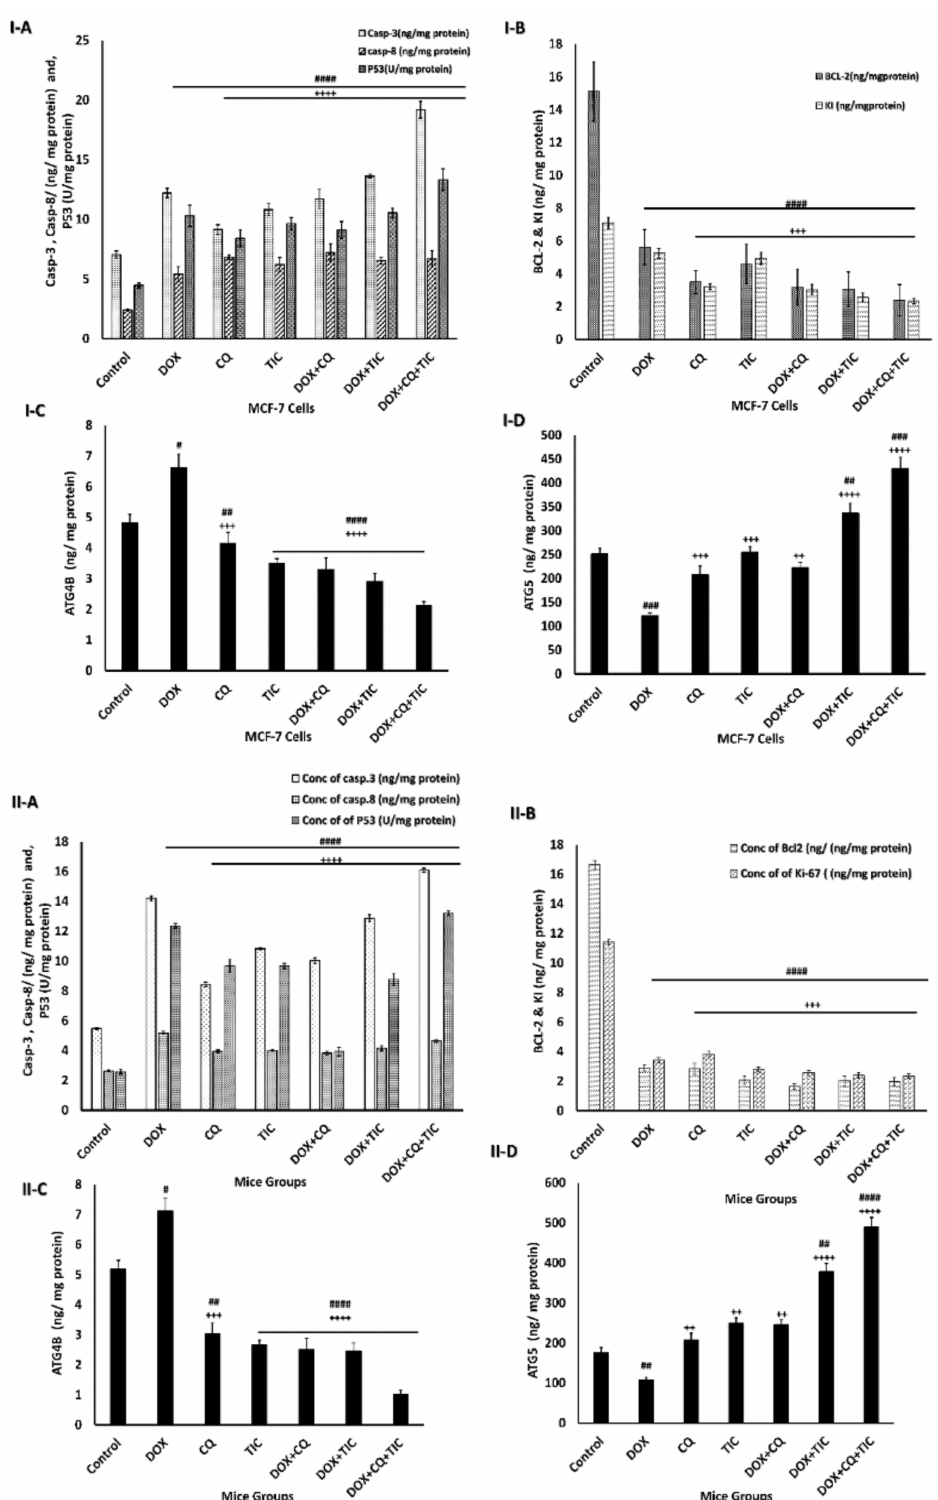
Figure 8. The disparity of apoptotic, anti-apoptotic, autophagy markers. Bar diagrams showing apoptotic markers as caspase-3, caspase-8, P53 ( A ), Bcl2, KI-67 as proliferation markers ( B ), ATG4B ( C ) and ATG5 ( D ) as autophagic markers of MCF-7 cells ( I ) and MCF-7 Xenograft mice ( II ) treated with single or combinatorial treatments. The data are presented as mean ± SE of at least three independent experiments. # p < 0.05, ## p < 0.01, ### p < 0.001, #### p < 0.0001 compared with control (untreated group). + p < 0.05, ++ p < 0.01, +++ p < 0.001, ++++ p < 0.0001 compared with the DOX treated